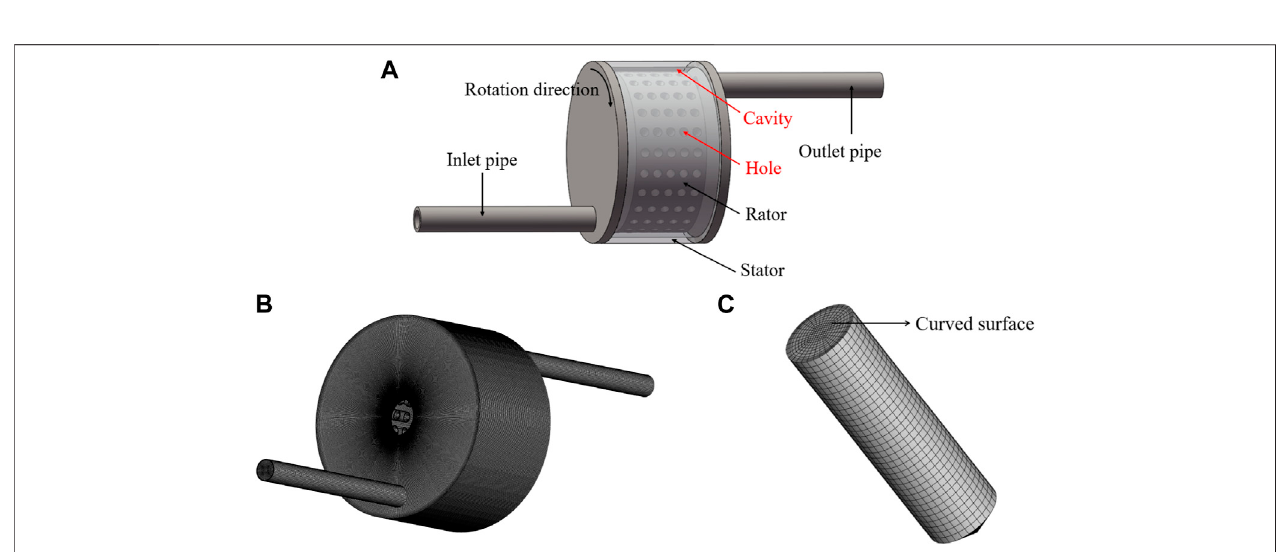
FIGURE 3 | The model and mesh of RHCR: (A) Schematic diagram of the RHCR, (B) Computing domain mesh, and (C) Single hole mesh.